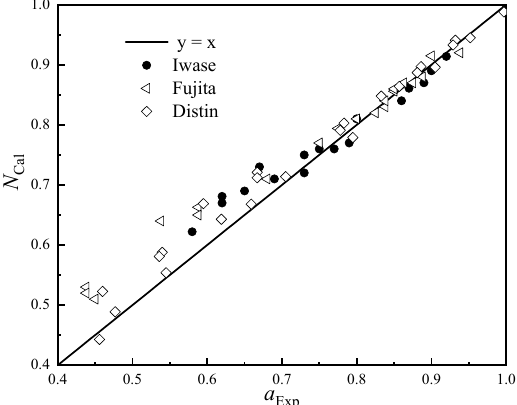
Figure 3. Calculated and measured activity values of FeO.